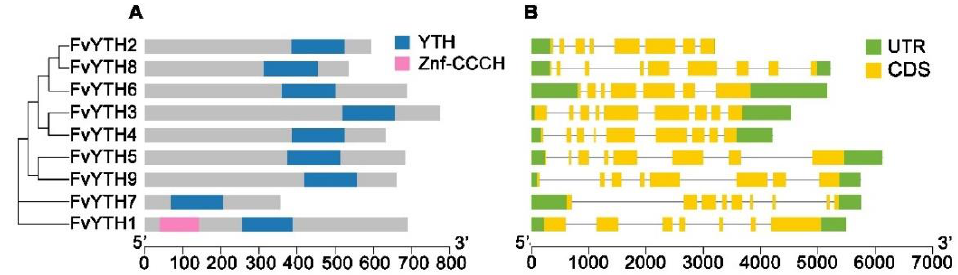
Figure 2. Gene structures and conserved domains of FvYTH proteins. ( A ) Conserved domains in FvYTH proteins. Pink box represents the Znf-CCCH domain, and blue boxes represent the YTH domain. ( B ) Exon/intron organizations of FvYTH genes. Yellow boxes represent exons, and gray lines represent introns. The upstream/downstream regions of FvYTH genes are indicated in green boxes.